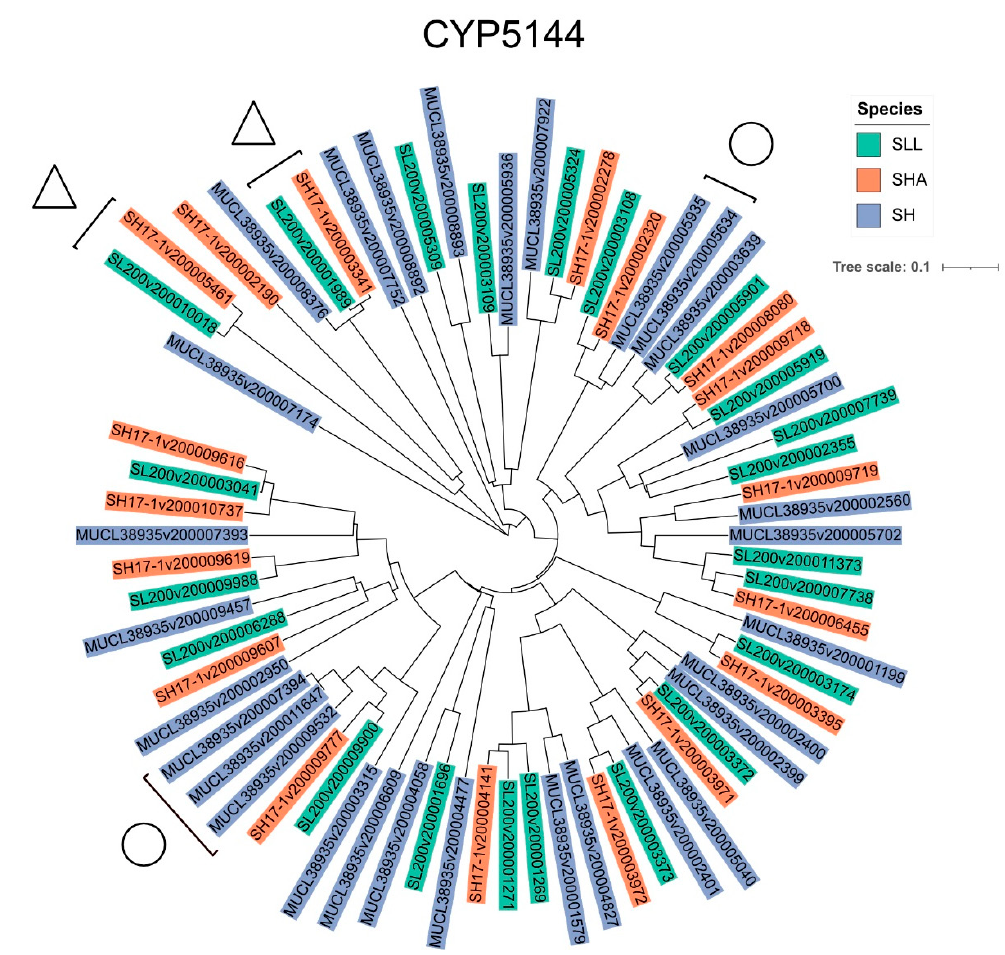
Figure 3. Phylogenetic analysis of putative CYP5144 family members in S. lacrymans var. lacrymans (SLL), S. lacrymans var. shastensis (SHA) and S. himantioides (SH). A minimum evolution tree for the 71 members assigned to this family was constructed using the close-neighbour-interchange algorithm in MEGA-X [20]. Evidence for gene orthologues highlighted by the triangles and examples of SH strain-specific enrichment in the P450 family through gene duplication events is shown by the circles. Constructs are coloured for each strain for ease of identification—gene prefixes are as follows: SL200 are SLL, SH17 are SHA and MUCL are SH.